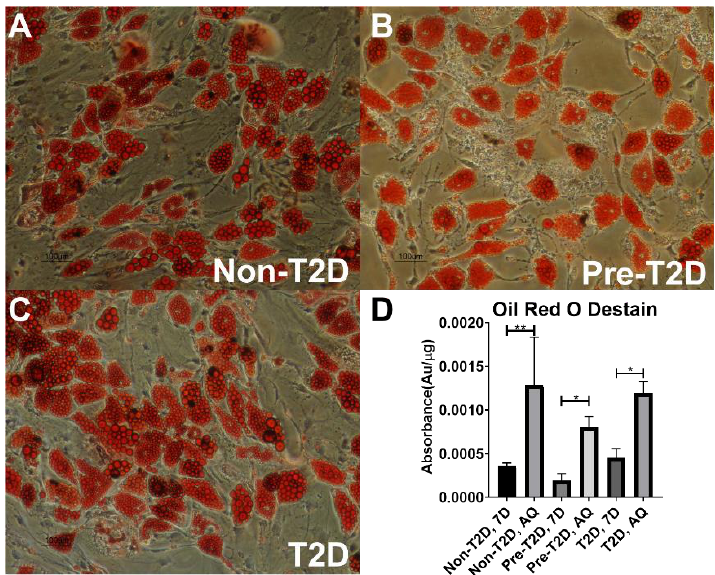
Figure 2. No significant differences in adipogenesis between IPFP-ASCS isolated from Non-T2D, Pre-T2D, and T2D donors. ( A – C ) Oil Red O representative image of IPFP-ASC cultured in Adi- poQual media for 28 Days (Scale Bar: 100 μm). ( D ) Isopropanol destaining of IPFP-ASCs cultured for 28 days in growth media or AdipoQual Media for 28 days ( n = 3, * p < 0.05, ** p < 0.01,). Non- T2D: Non-Type II diabetes mellitus, Pre-T2D: Pre-Type II diabetes mellitus, T2D: Type II diabetes